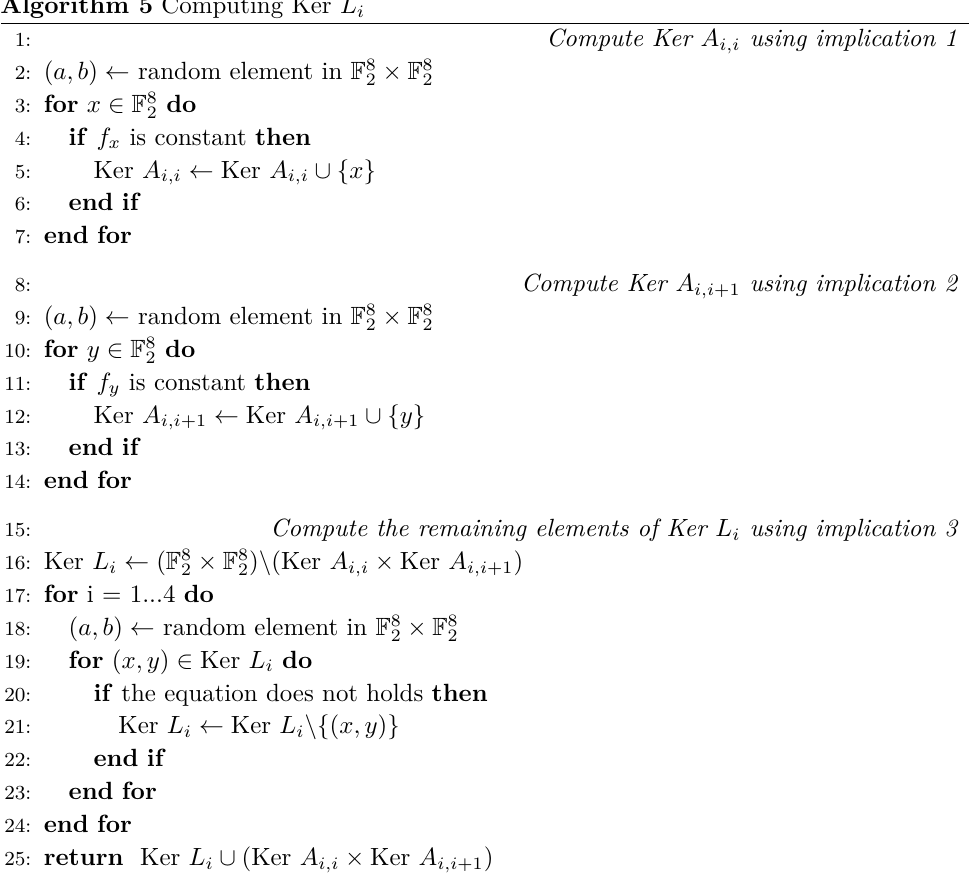
Algorithm 5 Computing Ker L